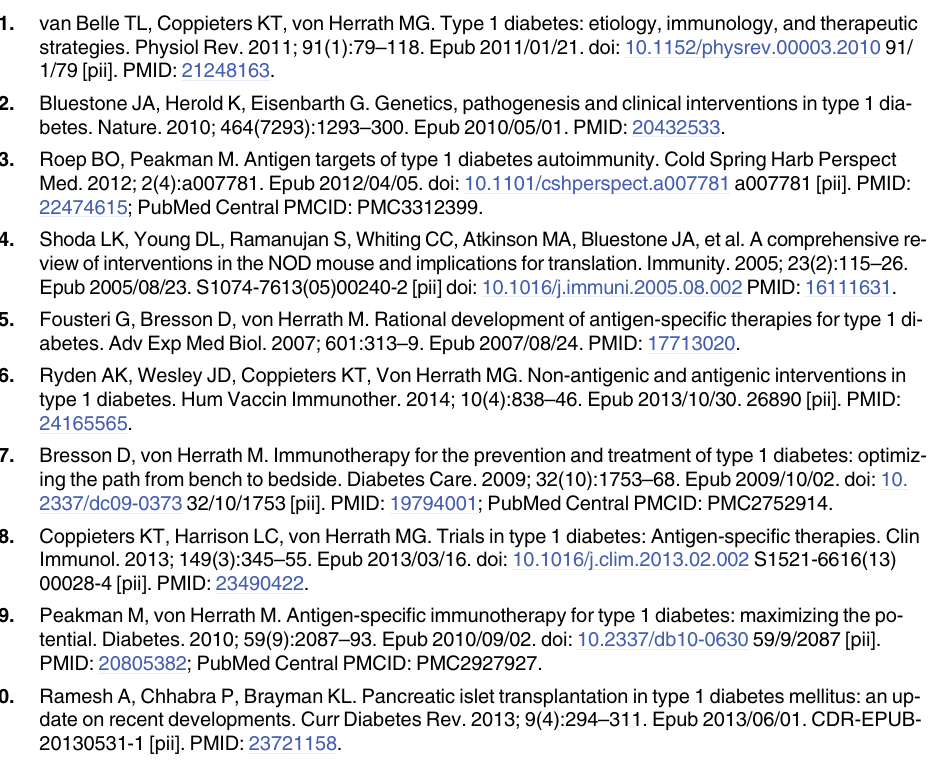
S2 Fig. InsB /IFA treatment does not alter the peripheral FOXP3 + Treg cell frequency 9 – 23 and number. Transplanted NOD mice were treated once s.c. with insB /IFA or PBS/IFA 9 – 23 (control). Flow cytometry was used to determine the frequency and total number of CD4 + FOXP3 + Treg cells in the blood, kidney draining lymph nodes (KdLN), graft and spleen 11 days after transplantation. A, Representative flow cytometry plots depict the frequency of /IFA-treated mice. 8- FOXP3 + CD4 + T cells in blood and spleen of PBS/IFA and insB 9 – 23 12-wk-old NOD unmanipulated normoglycemic mice were used as controls. B-F, the per- centage of FOXP3 + (Treg) cells gated on CD4 + T cells in blood (B), KdLN (C) and graft (D), as well as the percentage (E) and total number (F) of Treg cells in the spleen was assessed 11 days after transplantation. Unmanipulated, non-diabetic 8 – 12 wk-old NOD mice were used as additional control.